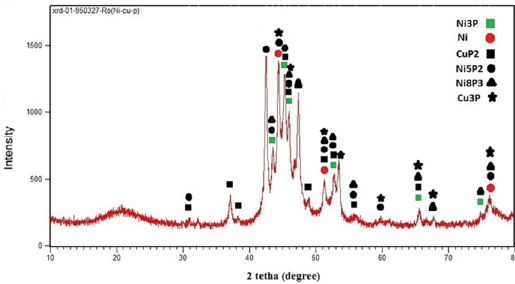
Figure 10. XRD analysis of Ni-P- 3(gr/lit) Cu coating after heat treatment for one hour at 400ºC